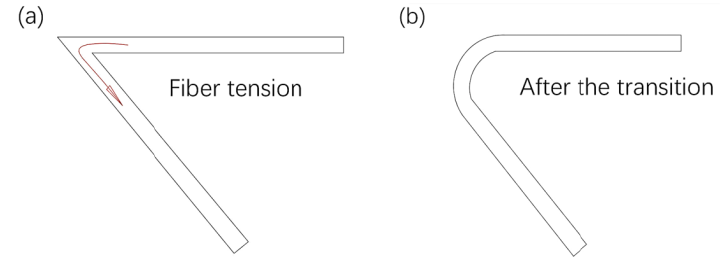
Figure 9. Actually print the transition curve after offset, ( a ) original track, ( b ) after the transition of external force.